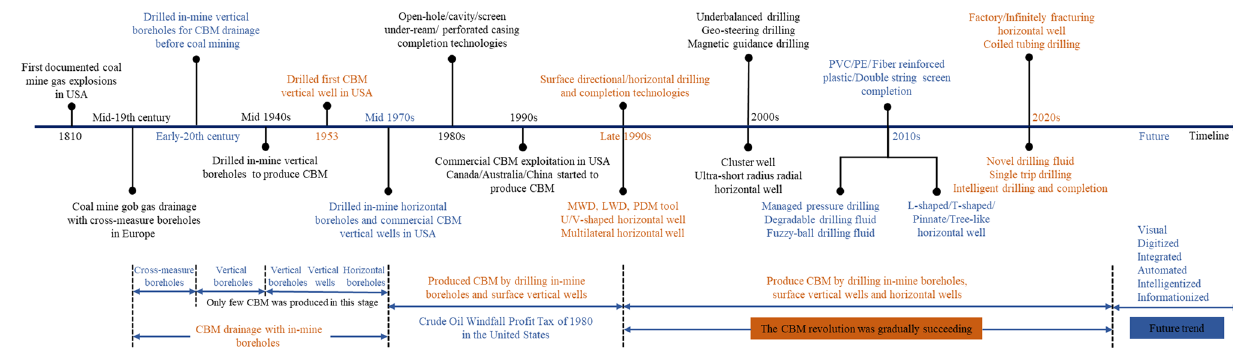
Fig. 30 Schematic of the developing process of CBM